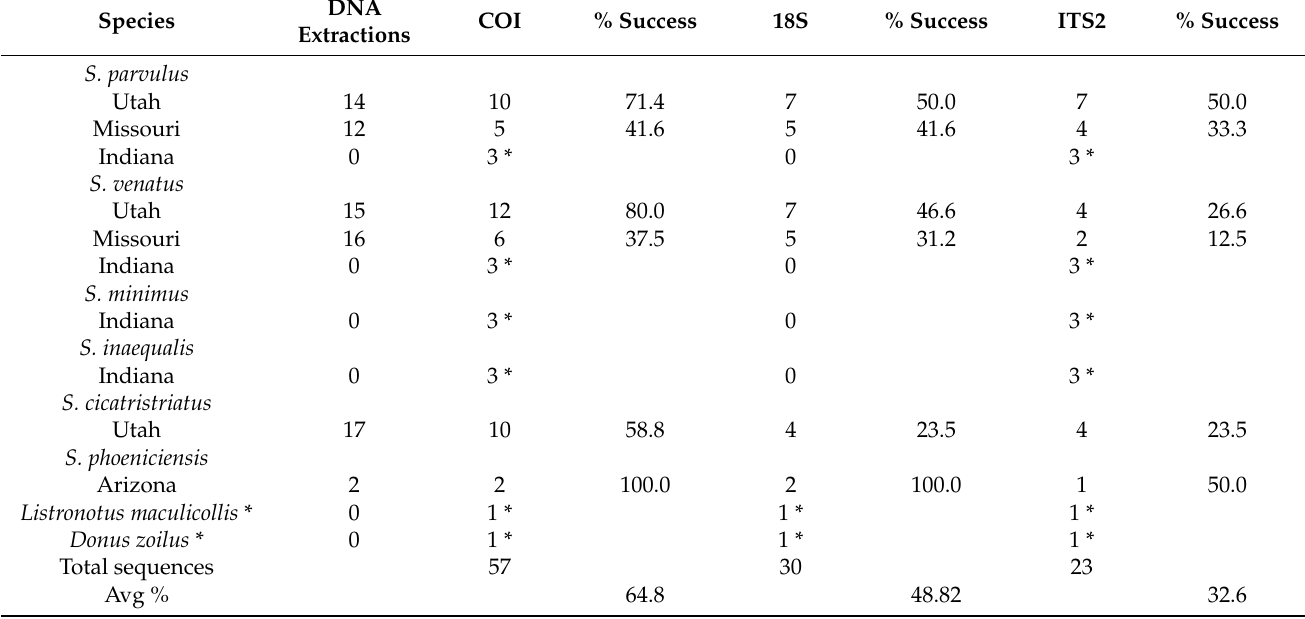
Table 2. Summary of DNA barcoding results used to create a reference sequence database from adult billbug ( Sphenophorus spp.) species collected in Indiana, Utah, Missouri, Arizona, and two outgroup species. The total number of DNA extractions performed, successful sequencing of PCR products (% Success) and total number of sequences included in the reference database are shown for each barcoding gene (COI, 18S and